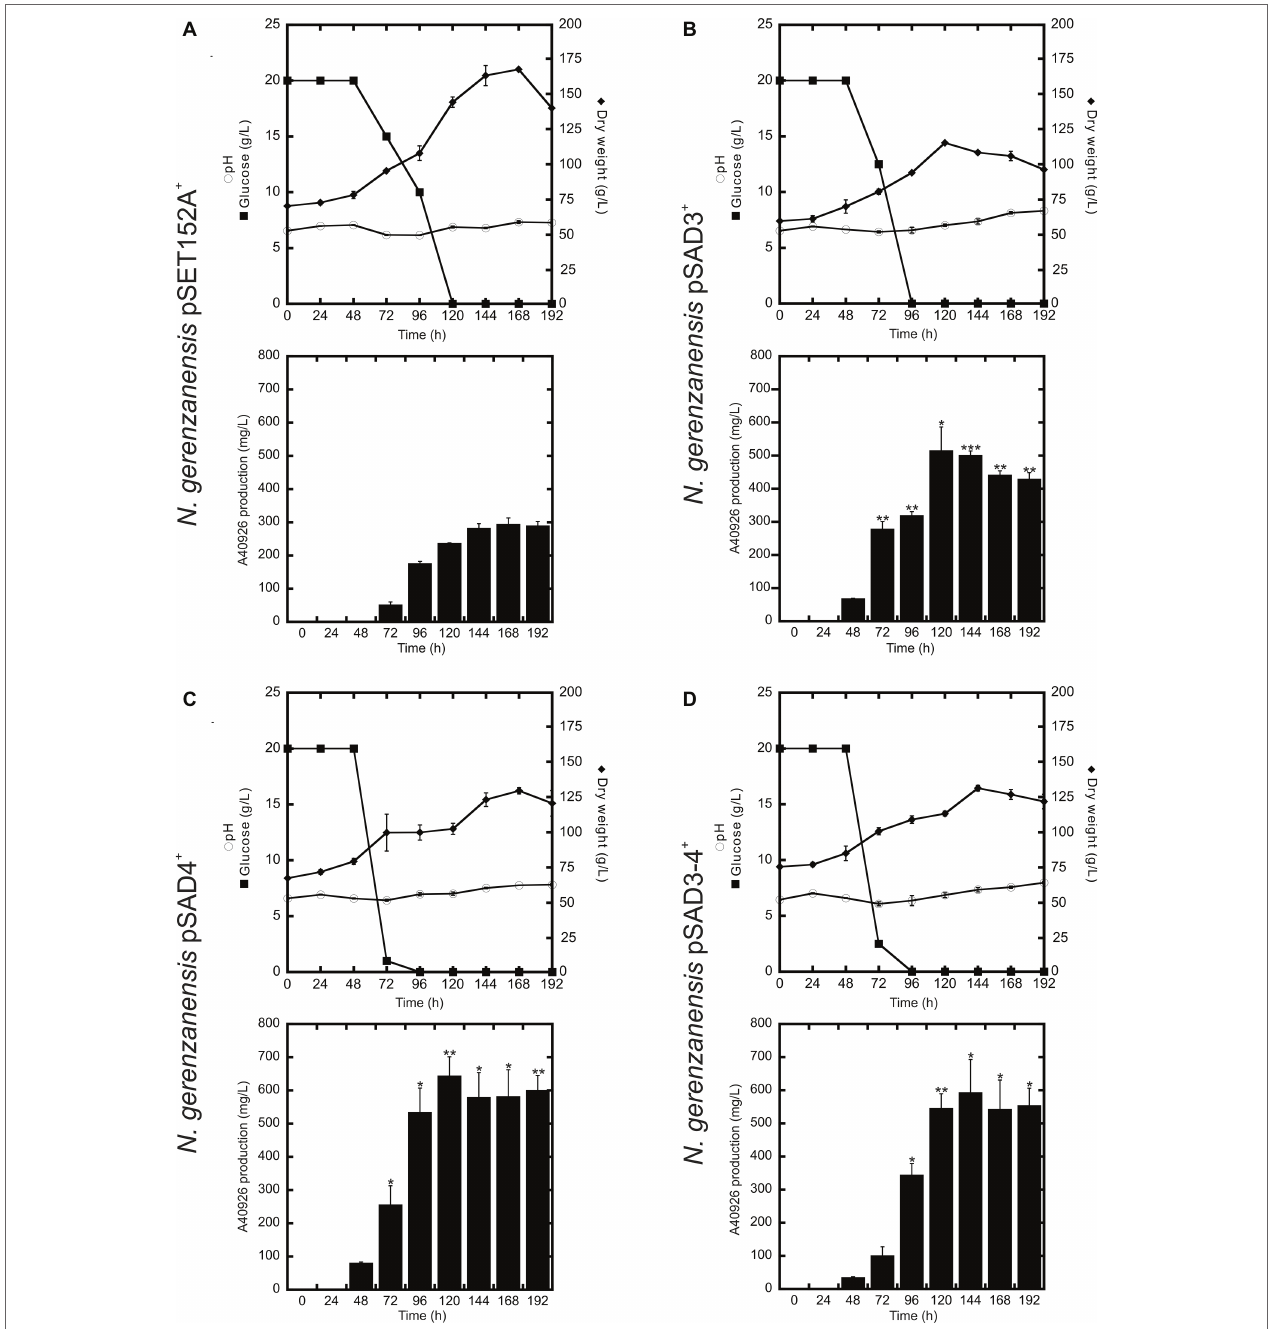
FIGURE 4 | Time courses of N. gerenzanensis pSET152A + (A) and recombinant strains overexpressing dbv3 (B) , dbv4 (C) and co-expressing both genes (D) cultivated in FM2 industrial medium in 500 ml Erlenmeyer flasks. Glucose consumption (filled rectangles), biomass accumulation (filled rhombi), pH (circles), and A40926 production were monitored every 24 h. Results given are mean values of three independent experiments. Error bars represent standard deviations. Statistical significance of the differences in A40926 production between the control and the recombinant strains was estimated using Welch’s t -test: * p < 0.05; ** p < 0.01; *** p <